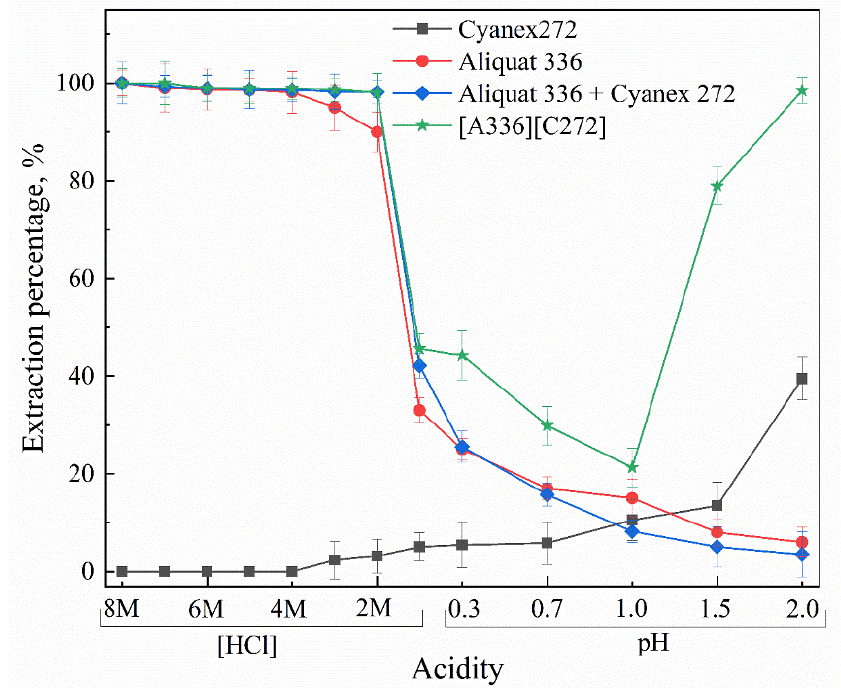
Figure 2. The effect of acidity on the extraction of Ga(III) using acidic extractants, Aliquat 336, binary mixtures and Bif-ILs.